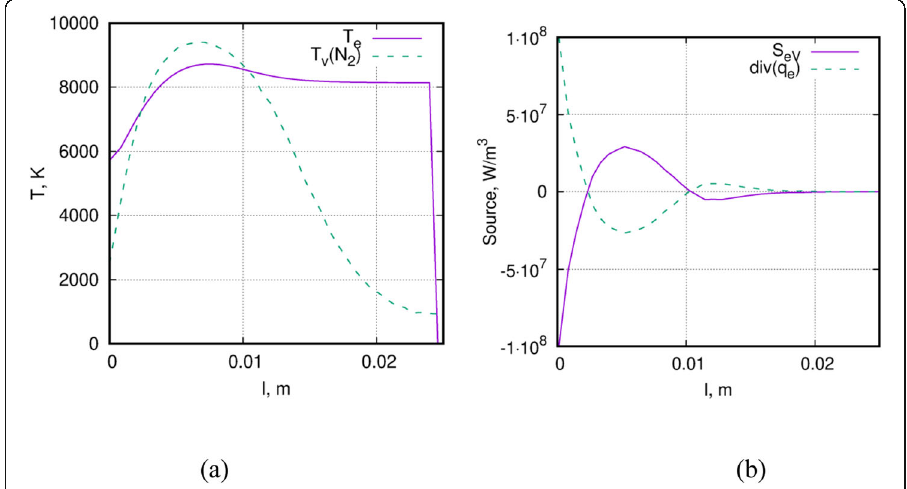
Fig. 5 Electron temperature and vibrational temperature along the stagnation streamline ( а ); profile of S eV and heat flux divergence ( b